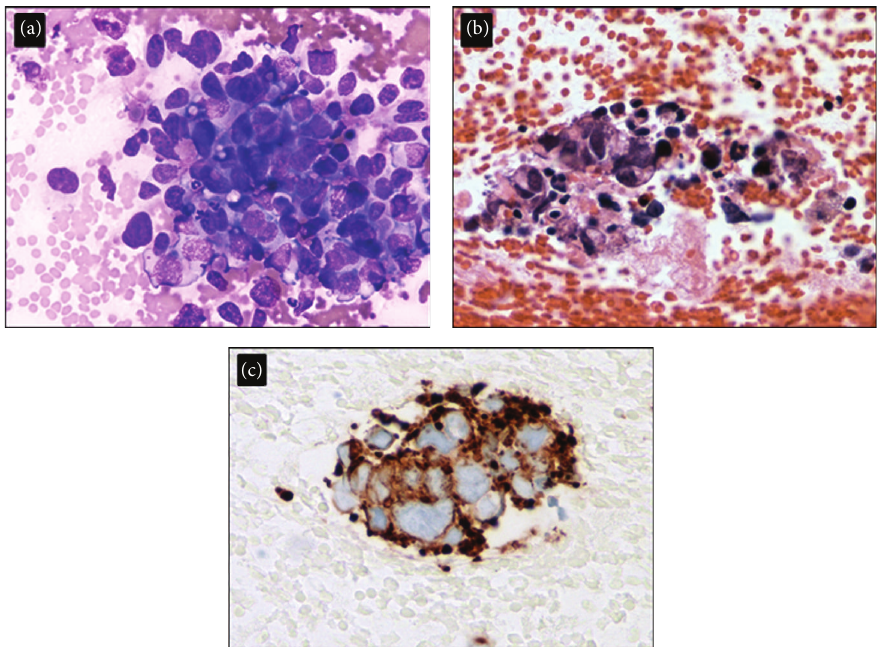
Figure 1: Parotid tumor pathology. Smear and cell block section from FNA biopsy showing pleomorphic malignant cells ((a) Diff-Quick stain, × 600; (b) cell block, × 600). The tumor cells are positive for Cam 5.2 ((c) × 600) and negative for AE1/AE3, p63, and CK5/6. Melan A, androgen receptor, mammaglobin, S-100, CD45, CD3, CD20, and TTF1. The cytological features with immunostaining results support a high grade